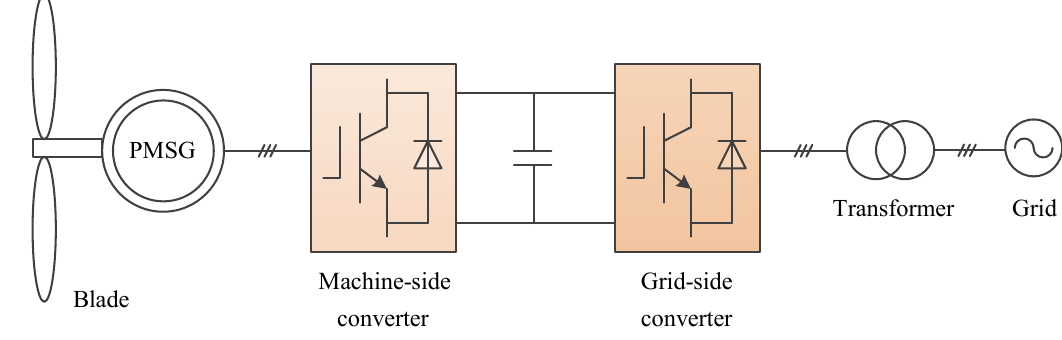
Figure 1. Structure of permanent magnet direct-drive wind turbine.